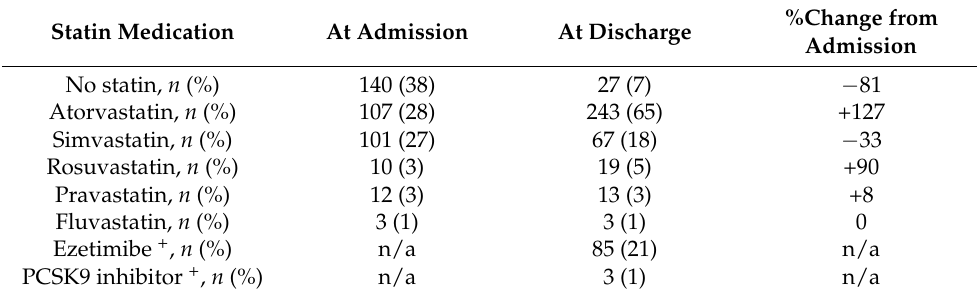
Table 2. Statin medication at admission and discharge.